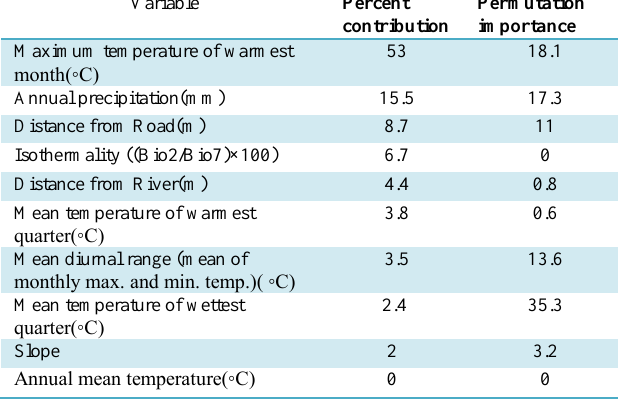
Table 3. Analysis of variable contributions